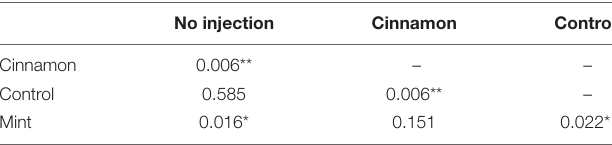
TABLE 2 | Pairwise permutational multivariate analysis of variance (PERMANOVA) comparisons for volatile organic compounds (VOCs) contained between treatments.